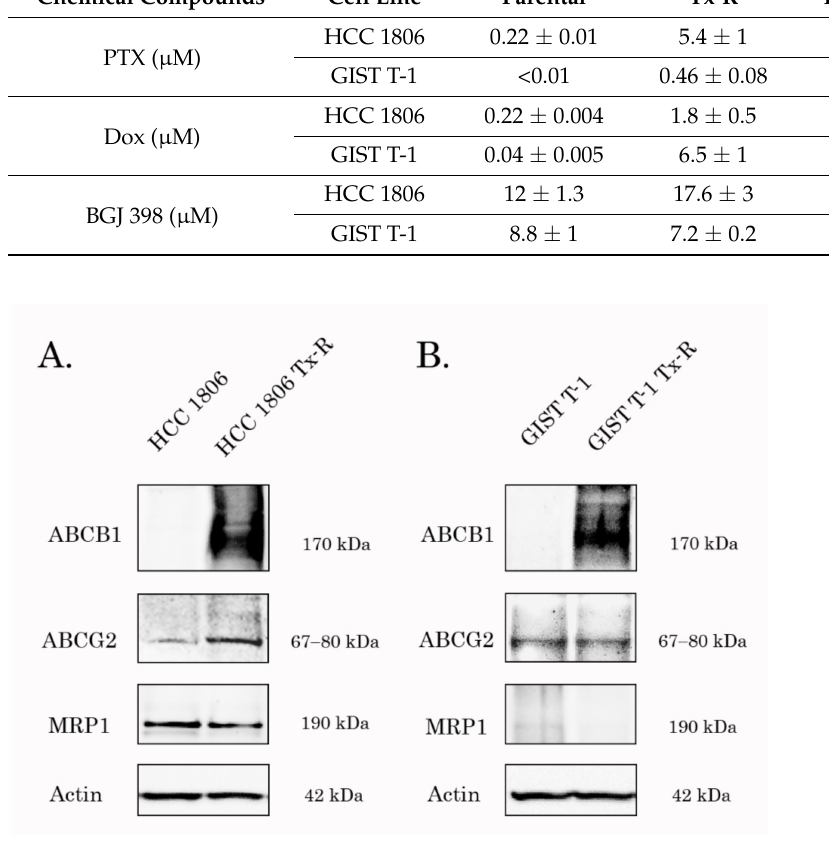
Figure 1. Expression of ABCB1, ABCC1 (MRP-1), and ABCG2 transporters in Tx-R cancer cells vs. Tx-sensitive parental HCC 1806 ( A ) and GIST T-1 ( B ) cells. Actin stain was used as a loading control. Thus, the resistance to PTX and Dox in TNBCs and GIST sublines indicated above might be due to the increased expression of ABC-transporters, in particular, ABCB1